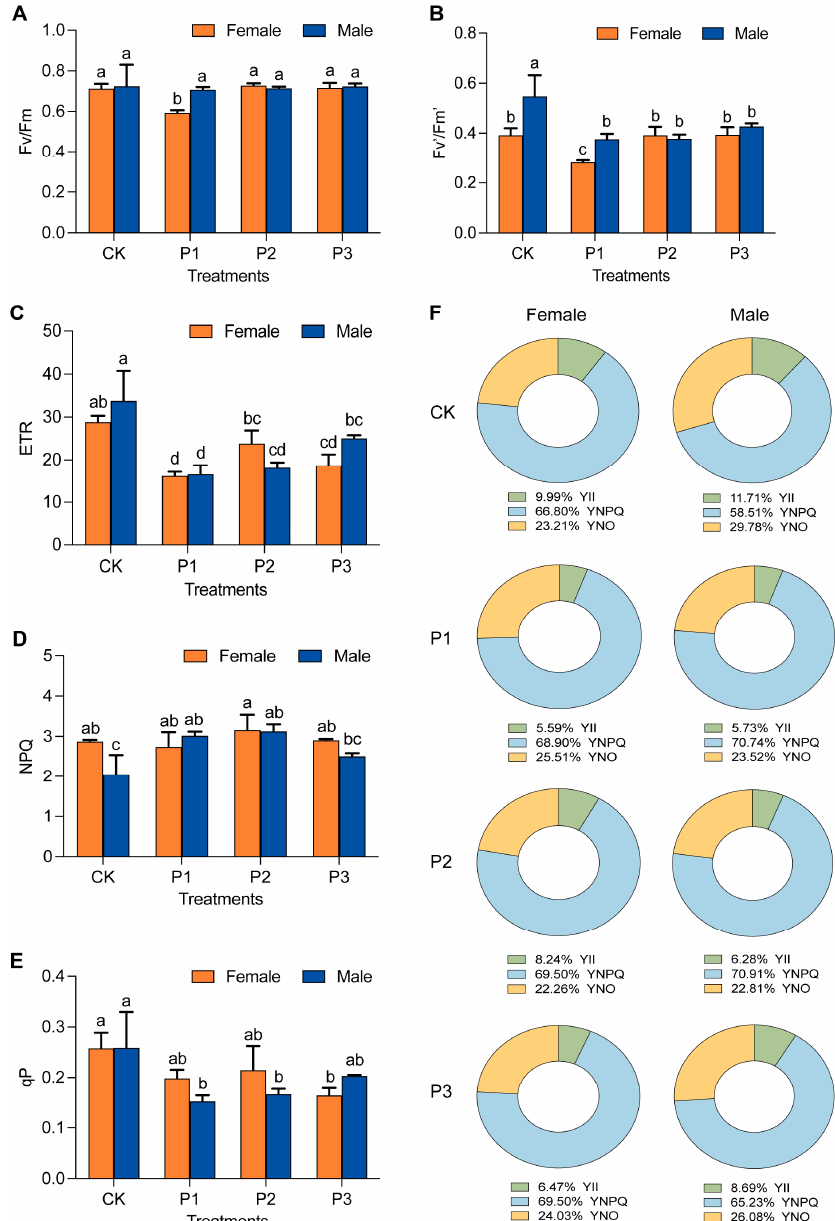
Figure 3. The Fv/Fm ( A ), Fv’/Fm’ ( B ), ETR ( C ), NPQ ( D ), qP ( E ), and PSII reaction center energy distribution parameters ( F ) of L. cubeba female and male leaves under control and Pb treatments. CK, P1, P2, and P3 represent 0, 1, 2, and 3 mmol Pb/kg dry soil, respectively. Values are the mean of three replicates ± SE. Values followed by different lowercase letters significantly differed, according to Duncan’s test ( p < 0.05).